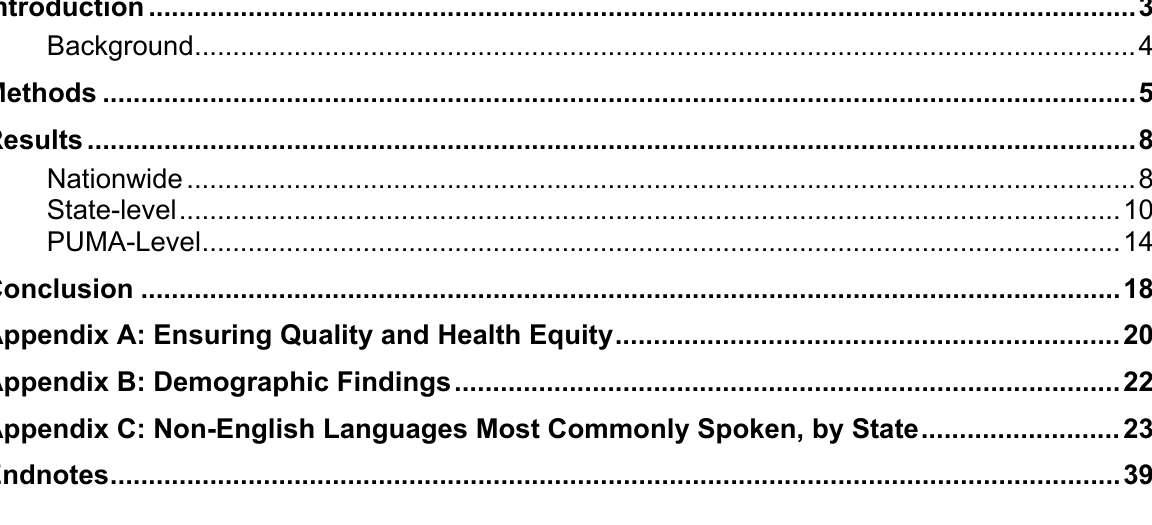
Figure 1: Percentage of Medicare Beneficiaries with and without limited English Figure 2: Non-English languages most commonly spoken by Medicare beneficiaries with Figure 3: States with highest prevalence of Medicare beneficiaries who are limited Figure 4: Prevalence of Medicare beneficiaries who speak English “less than very well” Figure 5: States with highest prevalence of Medicare beneficiaries who are blind or have Figure 6: States with highest prevalence of Medicare beneficiaries who are deaf or hard Figure 7: Example: Limited English proficiency among Medicare beneficiaries in Michigan ... 15 Figure 8: Non-English languages most commonly spoken by Medicare beneficiaries with Figure 9: Non-English languages most commonly spoken by Medicare beneficiaries